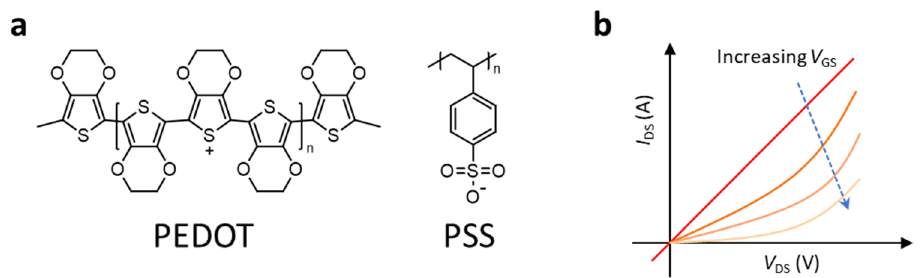
Figure 4. ( a ) Chemical structure of PEDOT:PSS. ( b ) The typical output curve of PEDOT:PSS depending on the gate voltage. The electrical conductance ( G = I V − 1 ) of PEDOT:PSS is decreased with increasing gate voltage due to a gating effect in the electrochemical transistor.